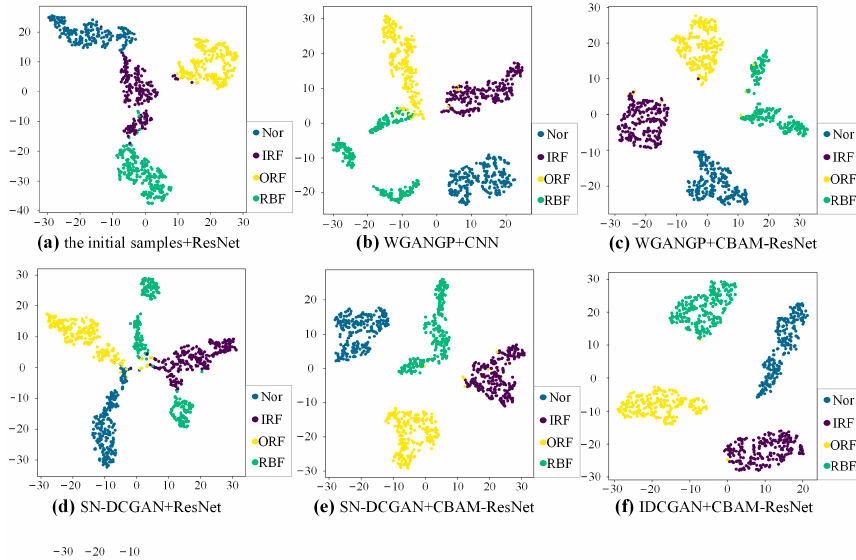
Figure 17. The t-SNE visualization results with different methods.